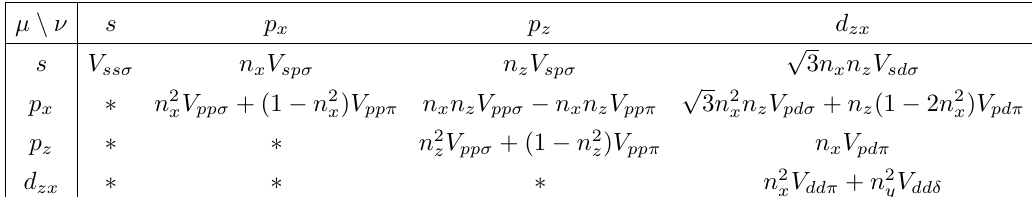
[79]. ~n ≡ ~r denotes the lattice j − ~r i µν